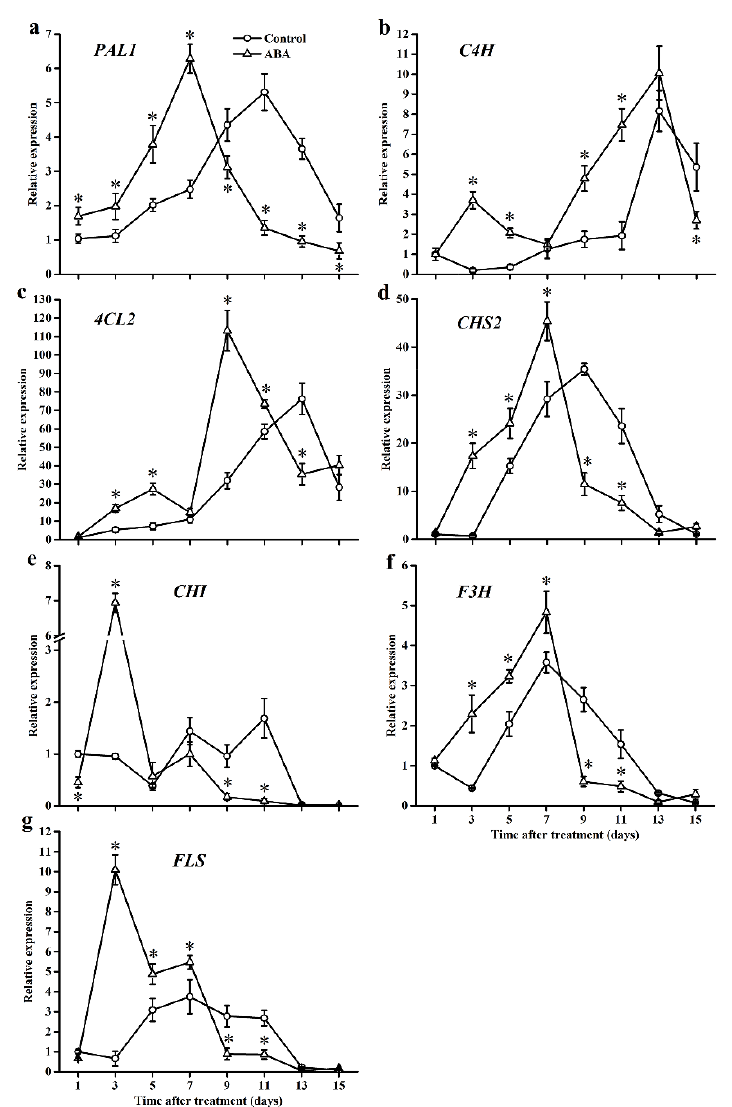
Figure 8. E ff ect of ABA on the gene expression of the phenylpropanoid pathway in the tomato during Figure 8. Effect of ABA on the gene expression of the phenylpropanoid pathway in the tomato storage at 20 ◦ C. Vertical bars represent the standard deviation (SD, n = 3). Asterisks (*) represent during storage at 20 °C. Vertical bars represent the standard deviation (SD, n = 3). Asterisks (*) significant di ff erences ( p < 0.05) between the ABA and control represent significant differences ( p < 0.05) between the ABA and control treatments.